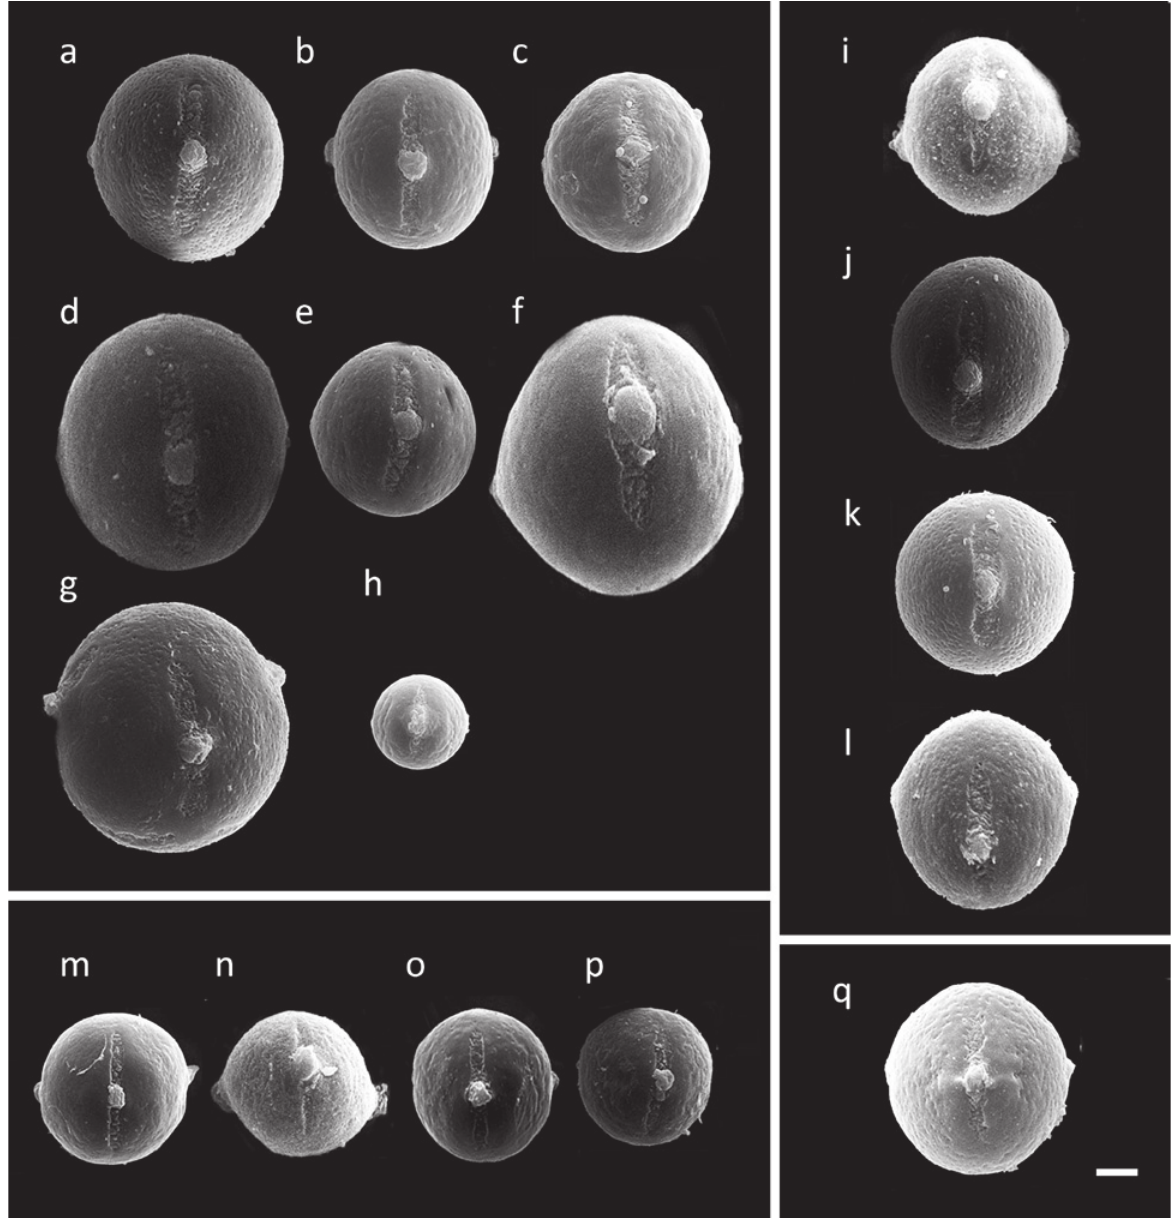
Fig. 2 - Pollen of 17 Lippia species in equatorial view. Zapania Schauer section: (a) L. alba , (b) L. aristata , (c) L. corymbosa , (d) L. diamantinensis , (e) L. hermanioides , (f) L. lacunosa , (g) L. rotundifolia , (h) L. rubella ; Rhodolippia Schauer section: (i) L. florida , (j) L. lupulina , (k) L. pseudothea , (l) L. rosella ; Goniostachyum Schauer section: (m) L. martiana , (n) L. pohliana , (o) L. salviifolia , (p) L. sidoides ; Dioicolippia Troncoso section : (q) L. filifolia . Bar = 8